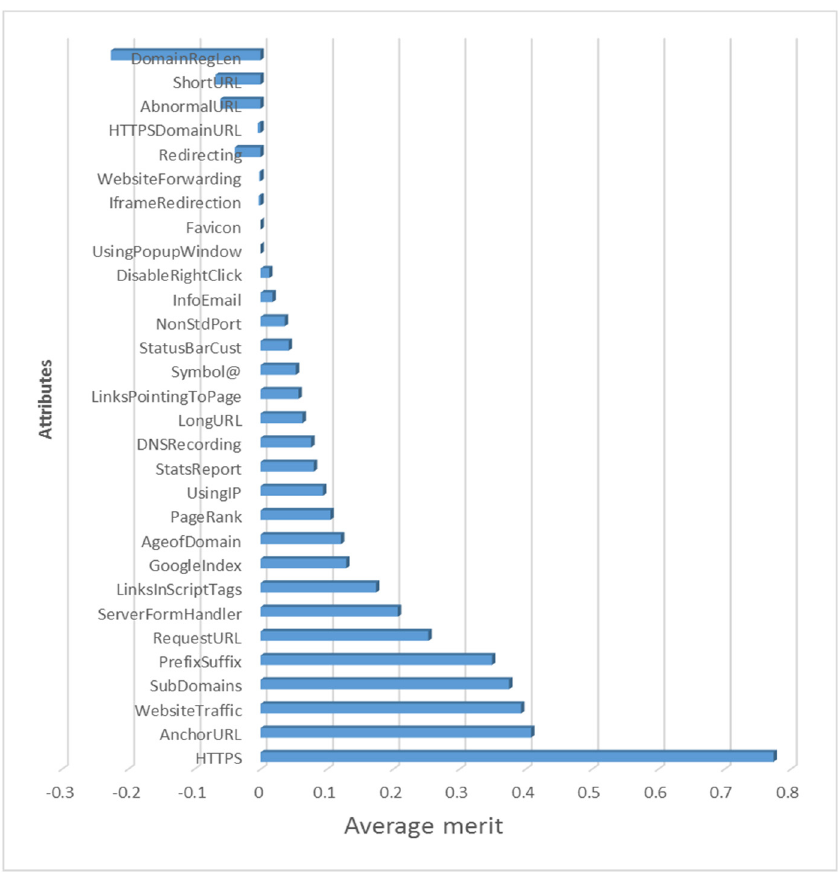
Figure 2. Average merits and ranks for website features. Table 2. Confusion